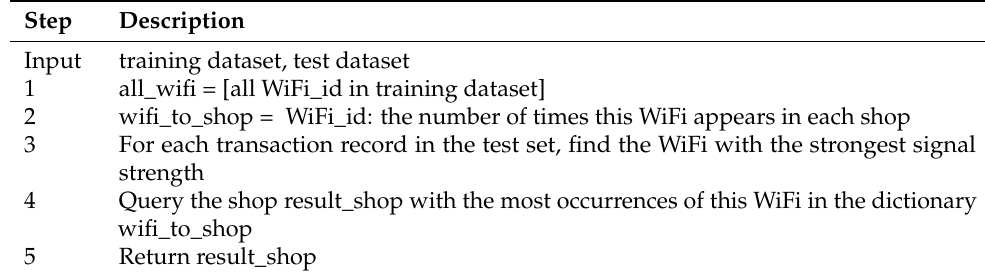
Table 4. Flow chart of the statistical rule algorithm.